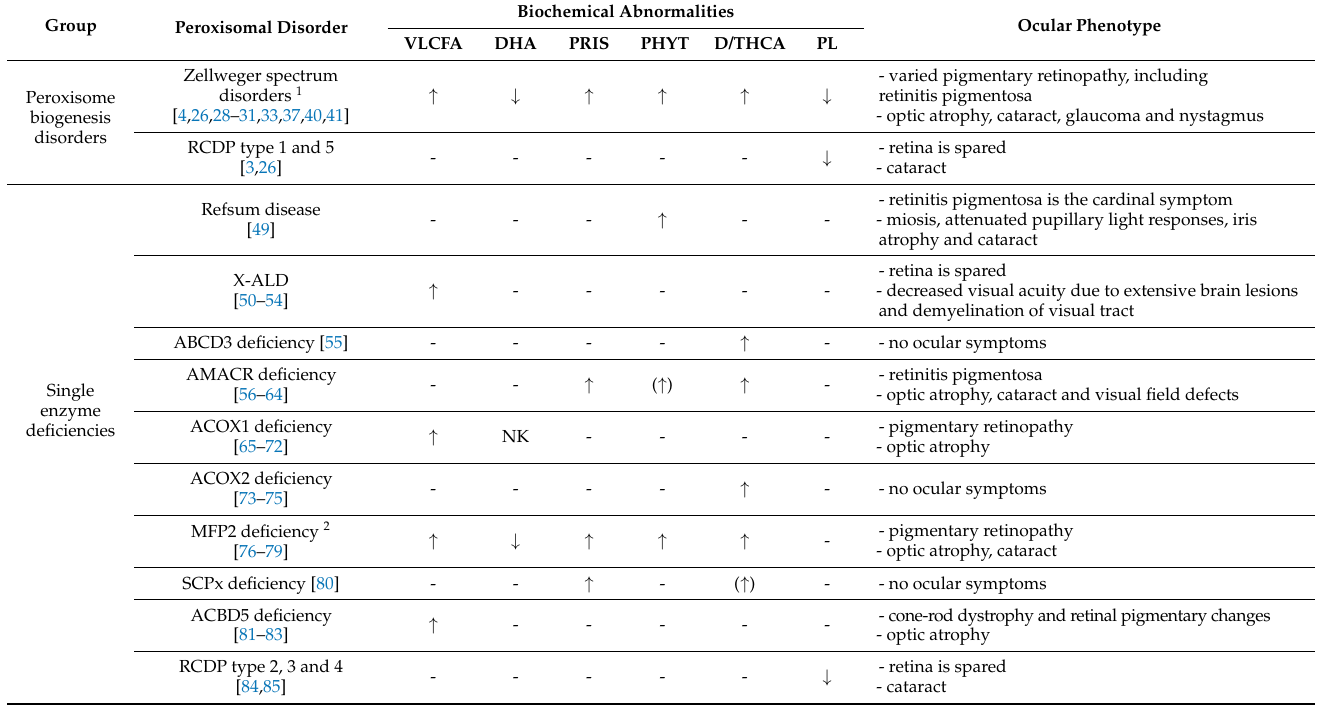
Table 1. Overview of the biochemical abnormalities and ocular phenotypes in peroxisomal biogenesis disorders and single enzyme